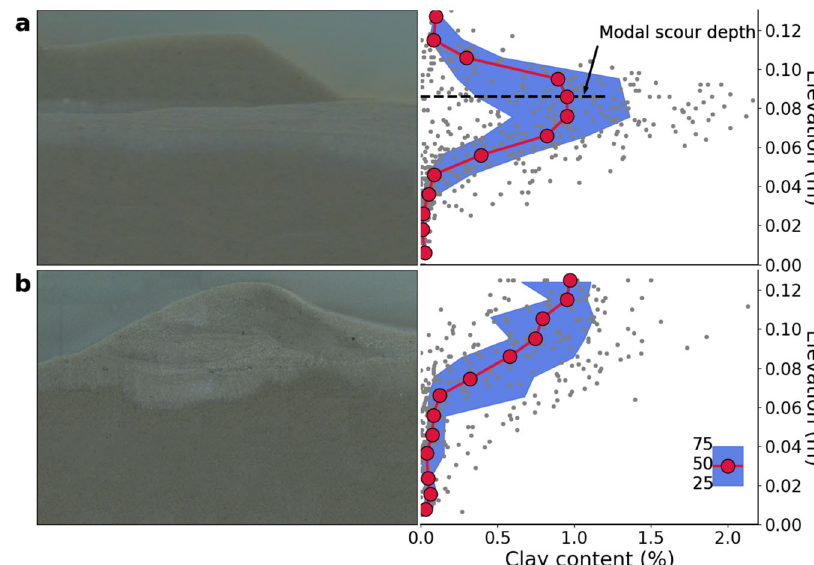
Fig. 3 Clay accumulation patterns for segregated and locked end states. Images on the left are representative images of the two end states, while concentration pro fi les on the right re fl ect clay accumulation in the sediment bed (see methods). Red circles denote the median concentration and shading represents the interquartile range. a In the segregated end state (NU-3), clay accumulates in a de fi ned layer just below the active layer of sand transport. The peak of the clay concentration pro fi le occurs just below the most frequent bedform scour depth. Clay also deposits below the maximum scour depth (~0.075 m), as clay is actively pumped underneath bedforms by hyporheic exchange. b In the locked end state (NU-8), extensive clay accumulation within bedforms halts bed motion. The clay deposition patterns re fl ect bedform-induced hyporheic pumping into the stoss slope and through the bedform. In this case, there is no de fi ned layer of buried clay and deposited clay concentration decreases monotonically with depth. Flow is from left to right in the images of bedforms. Images have been color matched to allow for easier visualization of clay